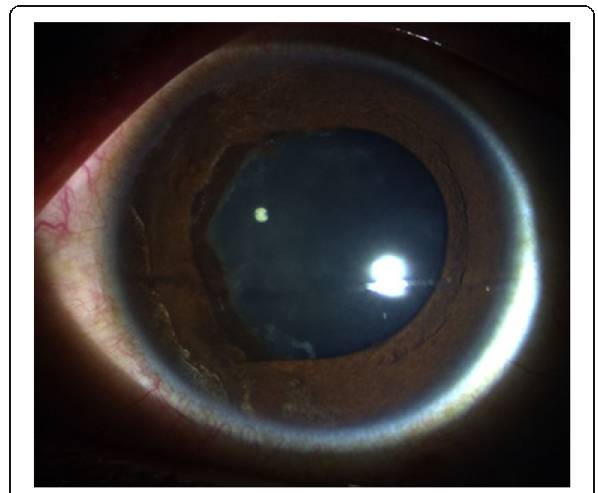
Fig. 11 Day 75 post-laser anterior segment slit lamp photograph, demonstrating velvety iris, pronounced pupillary synechia with anterior subcapsular cataract along its margins, persistence of anterior chamber + 1 – 2 cells and flare, and retrolental membranes with accompanying uncorrected visual acuity of 20/20